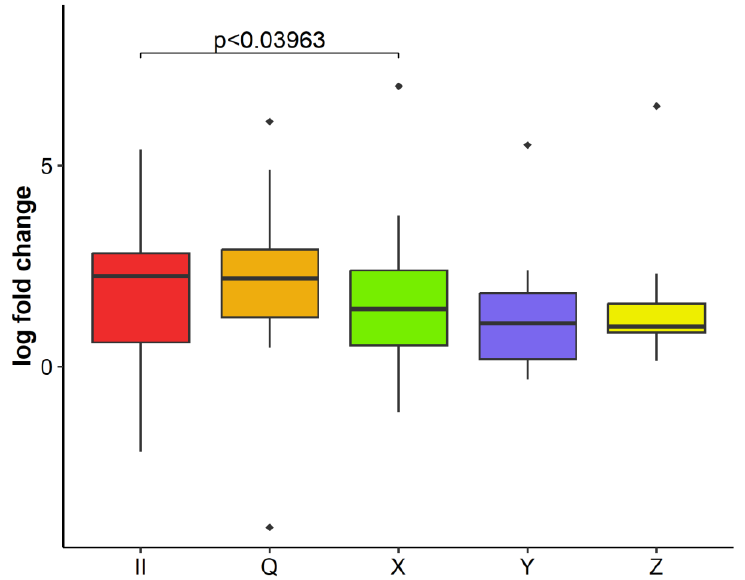
Figure 3. Multiple comparisons of relative concentration of GLRaV-3 ORF1a observed 16 months after inoculation of all plants of all varieties infected with the same inoculum (II, Q, X, Y or Z). Results are displayed as logarithmic ratios of relative concentration. ANOVA test was performed along with Dunnett’s post-hoc test and significantly different values ( p < 0.05) are marked over individual box plots. All concentrations were compared with the one of inoculum II (control) being the one harboring only GLRaV-3. Outlier measurements that are 1.5 times over the upper/lower quartile of the dataset of an individual boxplot are marked with ◆ .